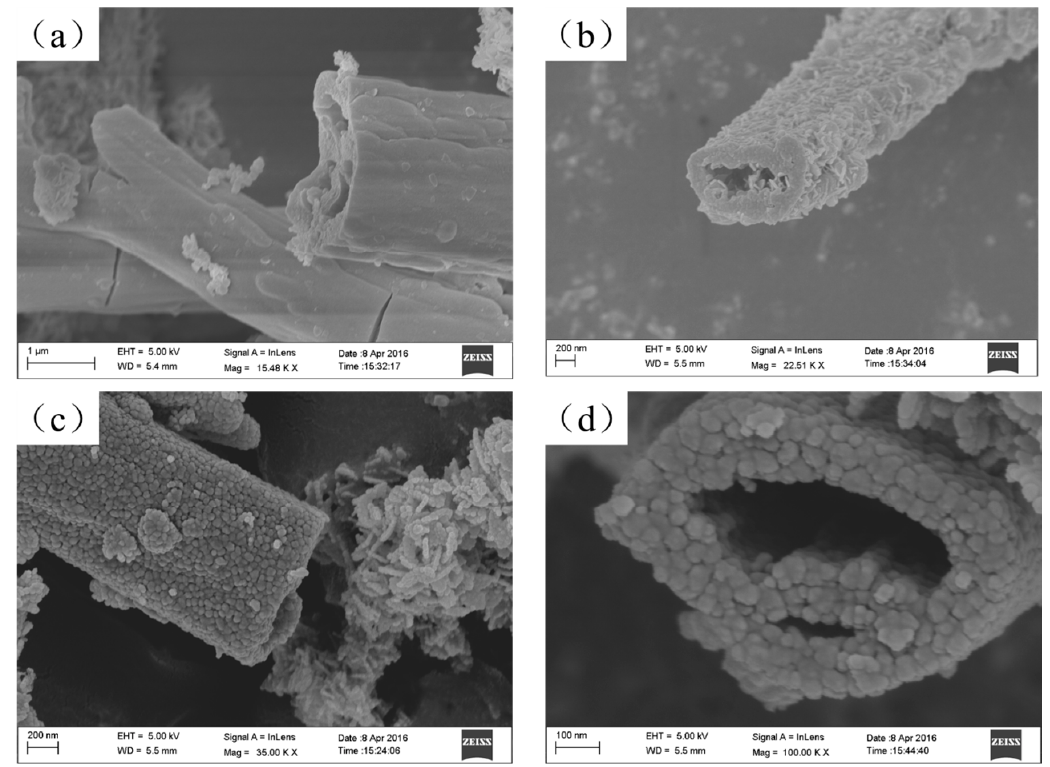
Figure 3. SEM images of ( a , b ) sample T2 and ( c , d ) sample T4.